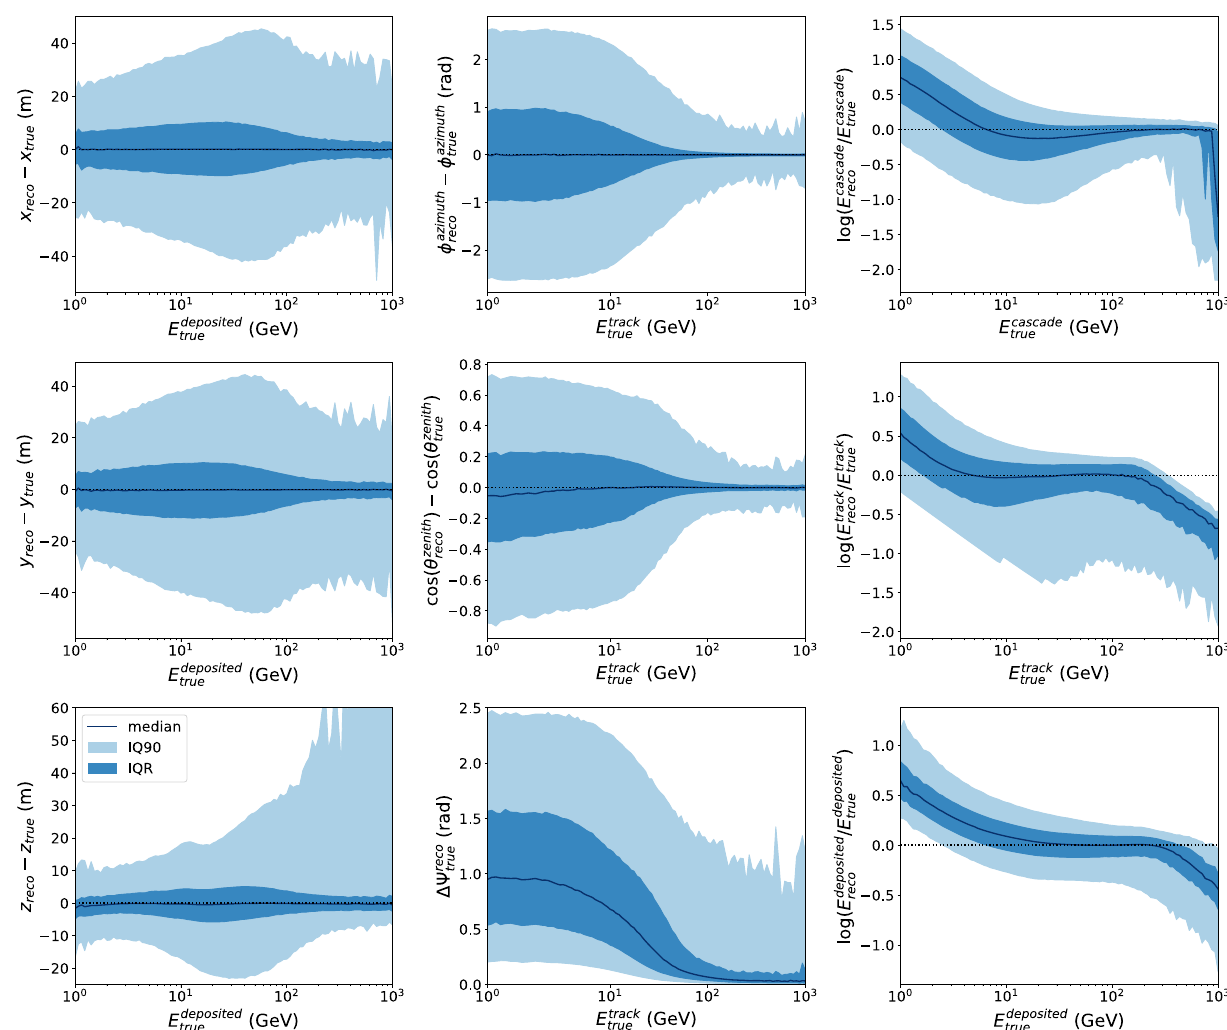
Fig. 19 retro resolutions vs. true (total) deposited energy for vertex position and total energy. For the angular resolutions, the true track energy is used instead of the true deposited energy. In addition to azimuth and zenith resolutions also the angle between reconstructed and true direction ( (cid:5)(cid:15) reco true ) is shown. The single cascade and track